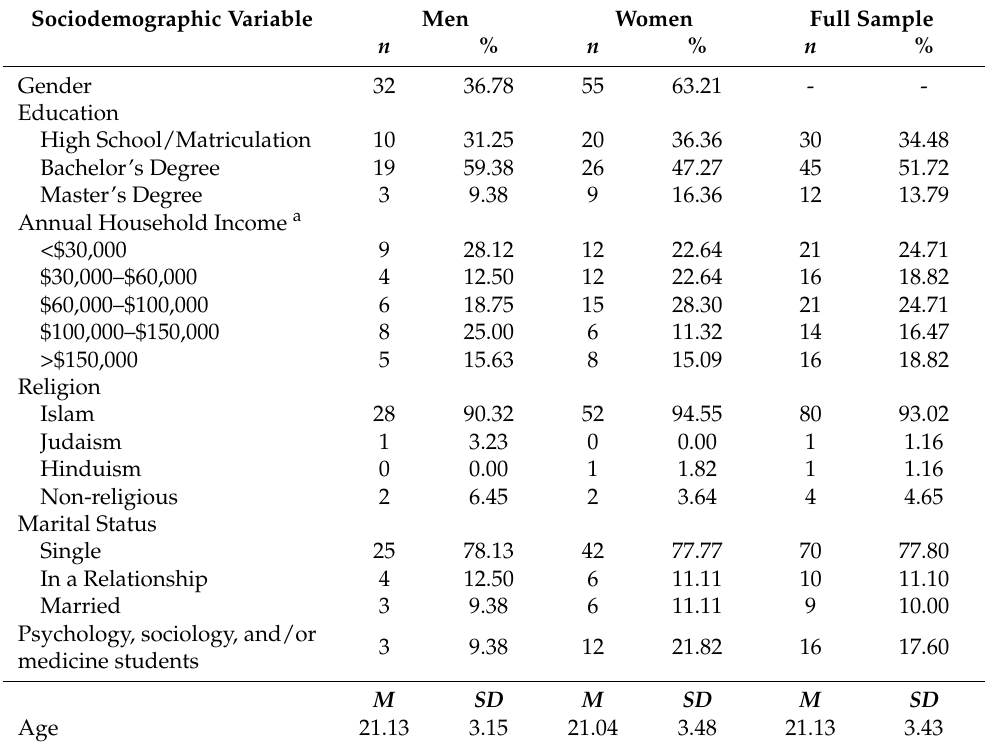
Table 1. Sociodemographic Information Related to Study Participants ( N =